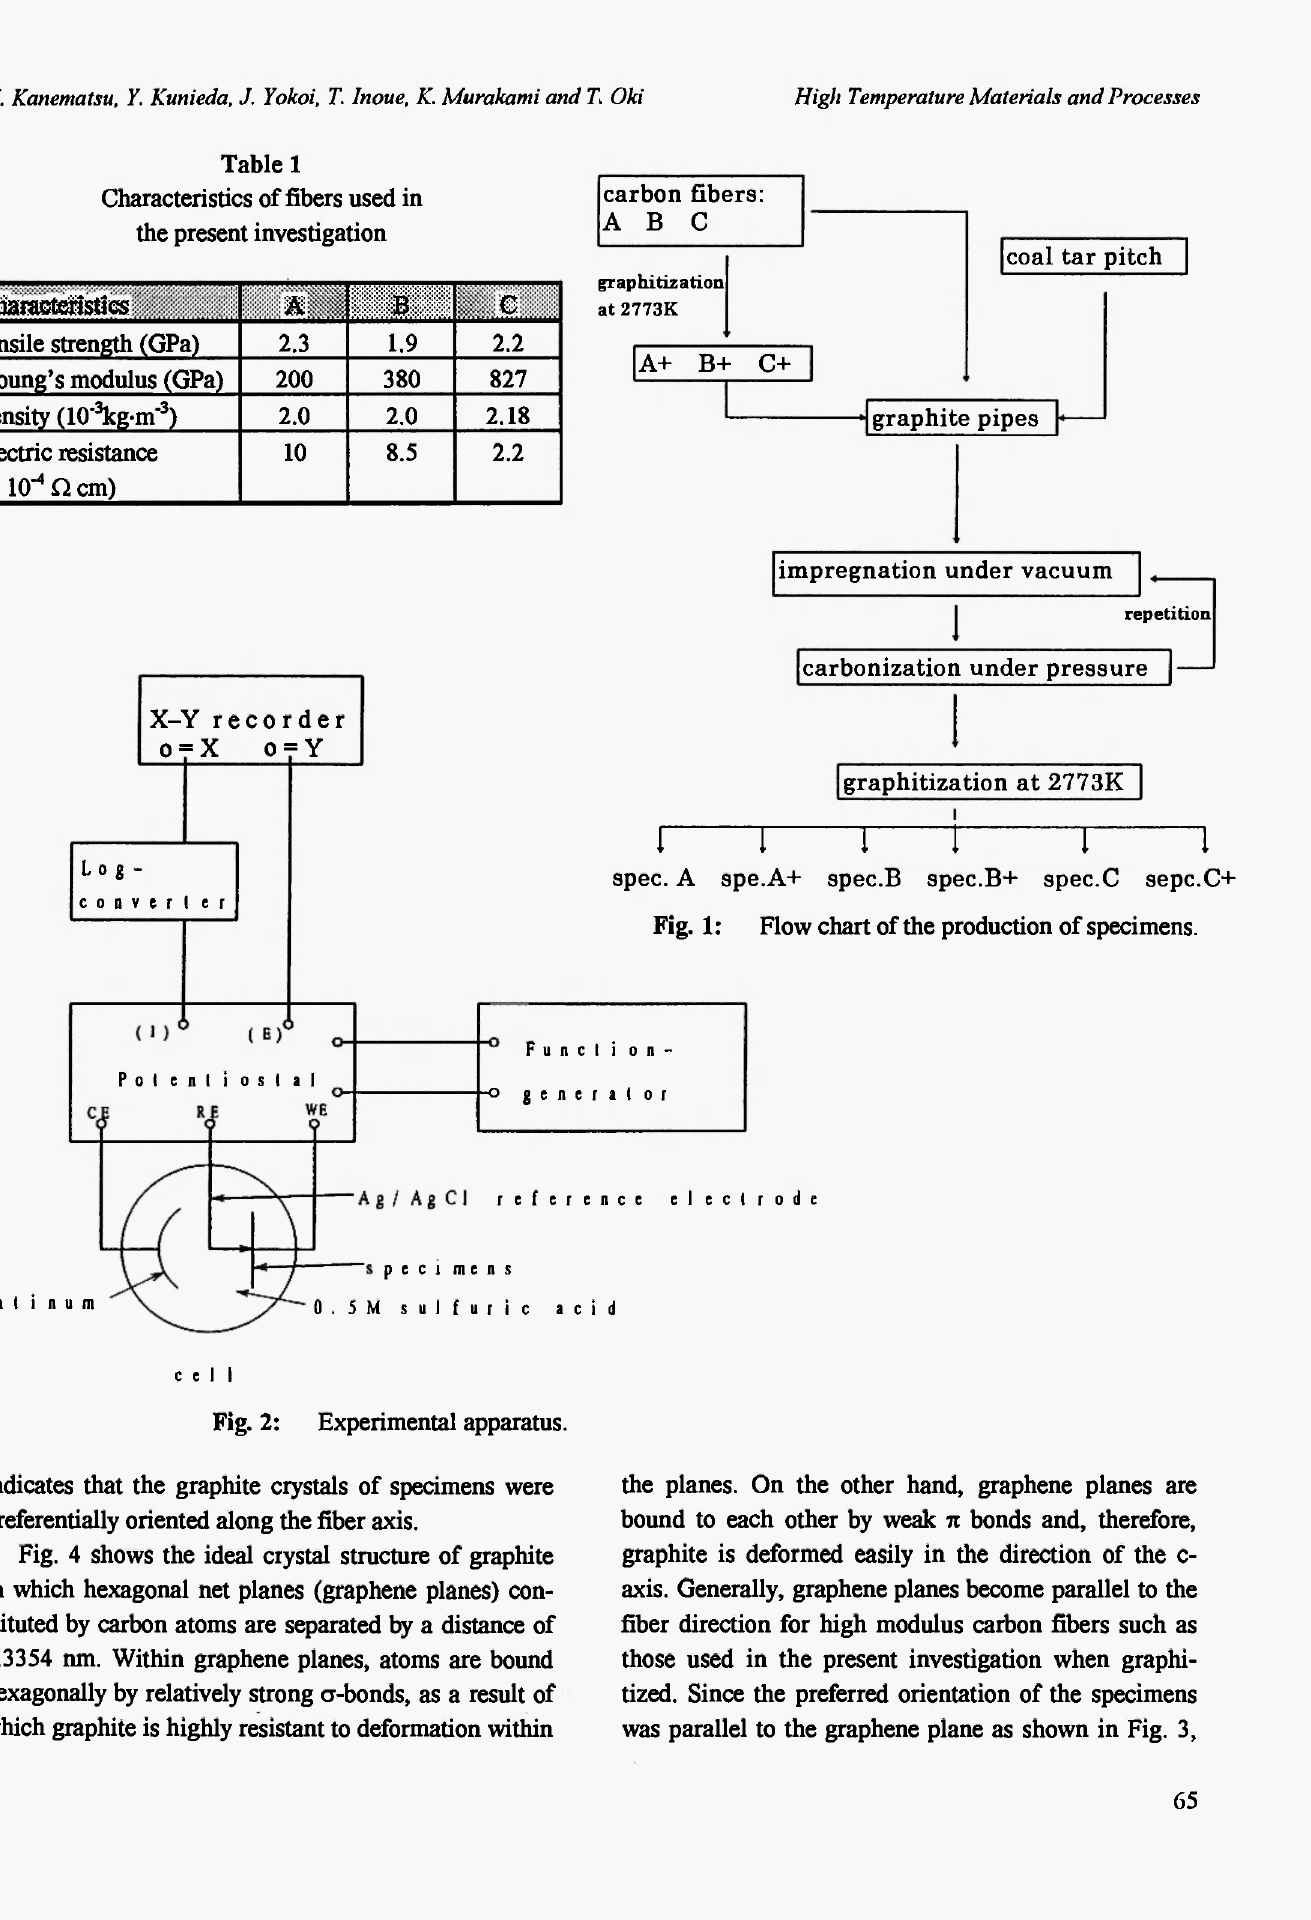
Fig. 1: Flow chart of the production of specimens.